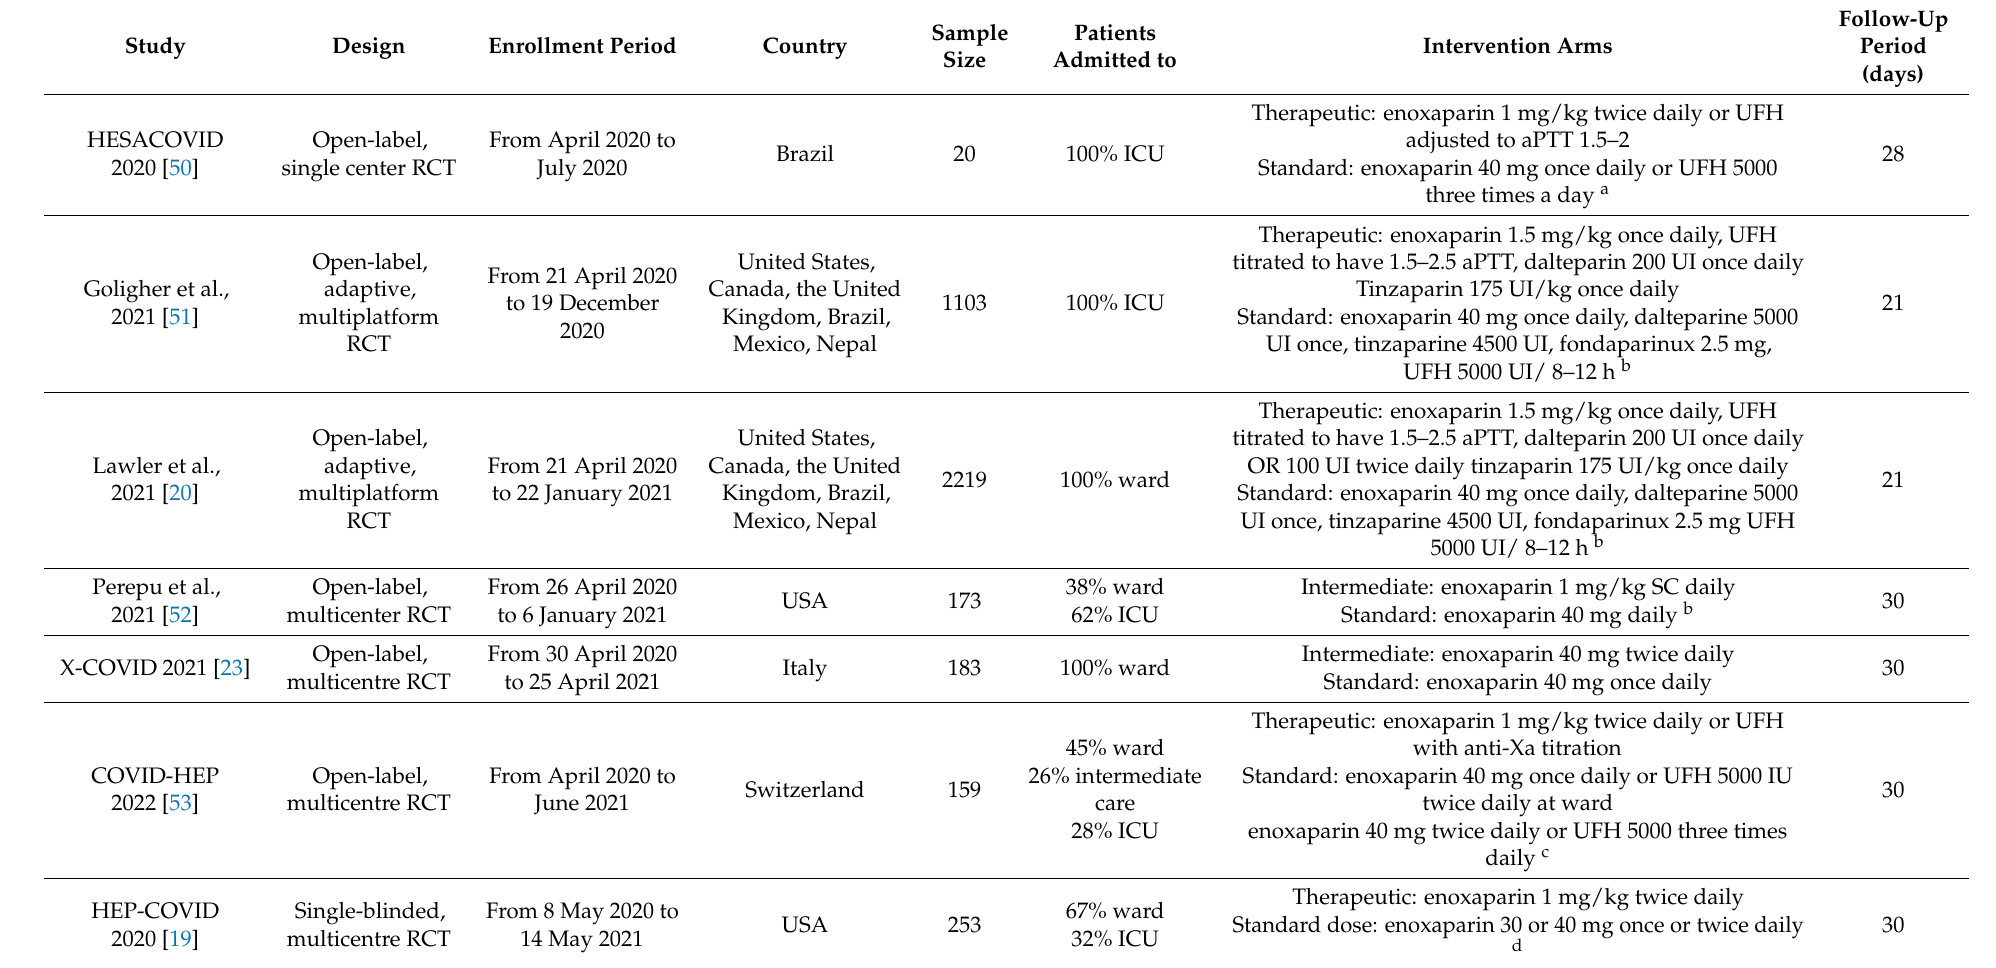
Table 1. Characteristics of included